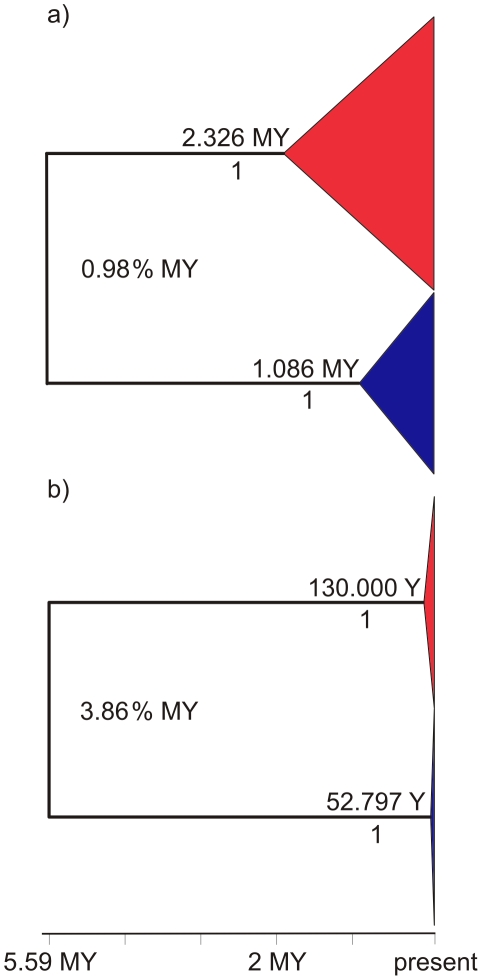
Consensus Trees of the Carcinus genus.Trees showing inferred rates and times of the most recent common ancestor (tMRCA) of C. aestuarii (red) and C. maenas (blue) assuming a total tree height of 5.59 MY. tMRCAs are reported above the branches, and posterior support for the corresponding node, below. (a) Estimates obtained using phylogenetic priors and only unique haplotypes, and (b) Using demographic priors and all sequences.